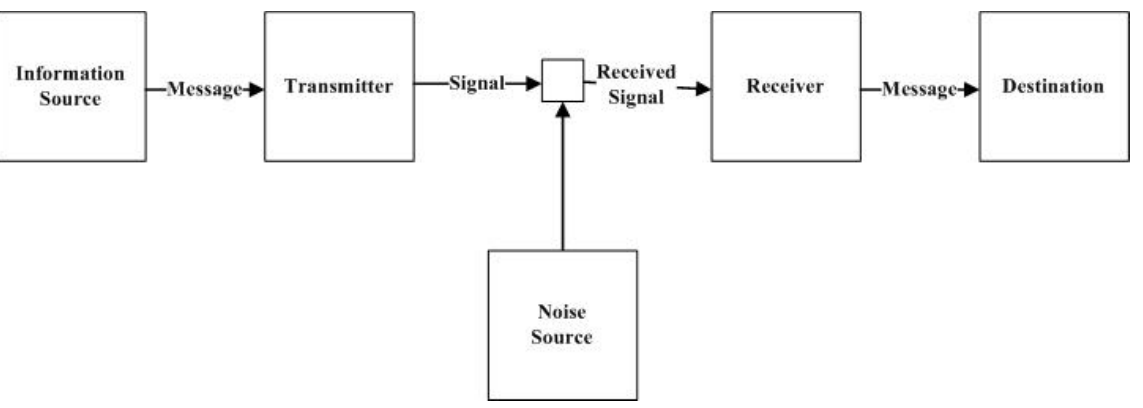
Figure 4 Schematic diagram of a correction system (Shannon